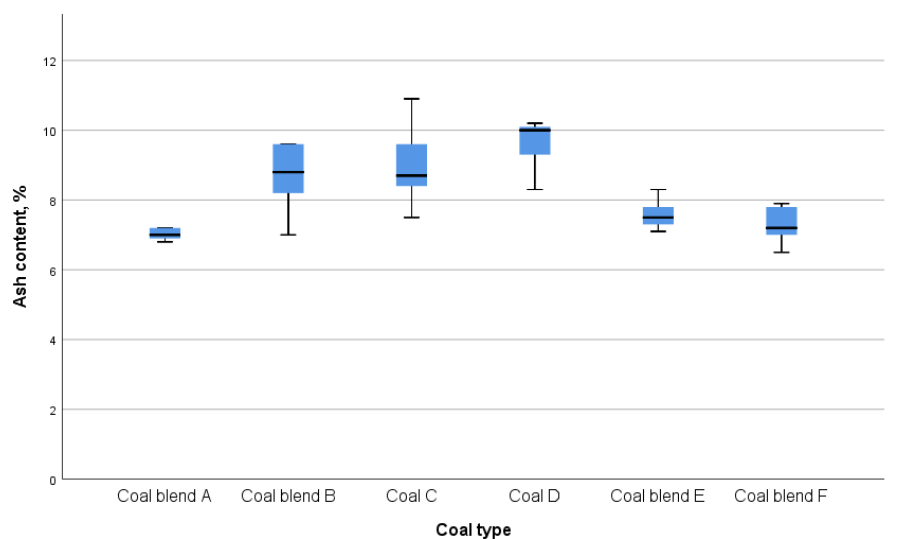
Figure 2. The ranges of the measured ash contents for the oven-dried coals and coal blends used during the study periods.